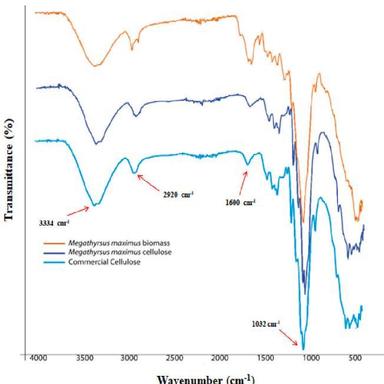
FTIR spectrum of MMB, MMC, and CC.